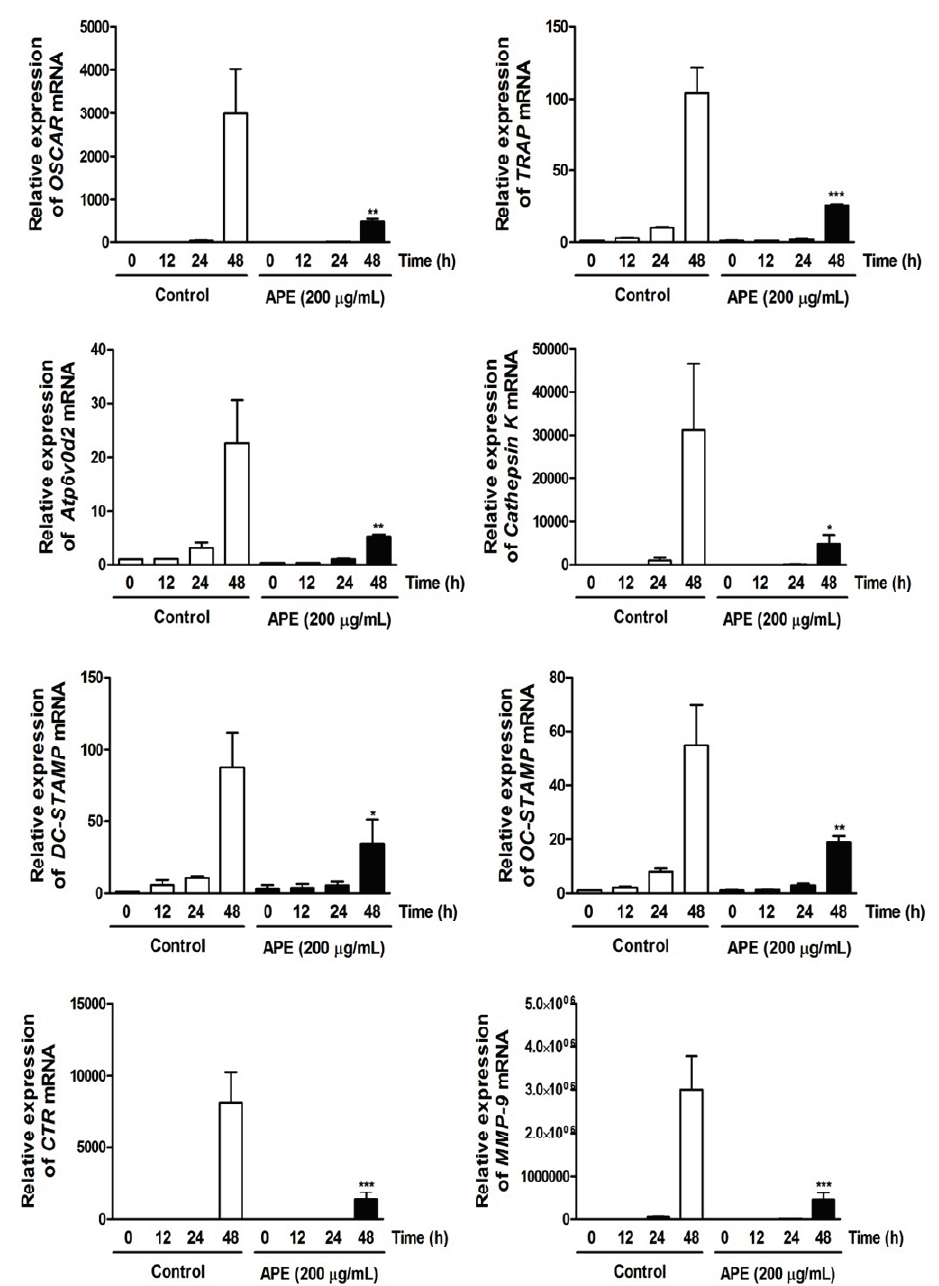
Figure 5. Aconitum pseudo-laeve var. erectum (APE) down-regulates the expression of osteoclast-specific marker genes. Bone marrow macrophages (BMMs) were stimulated with receptor activator of nuclear factor kappa-B ligand (RANKL; 100 ng/mL) and macrophage colony-stimulating factor (M-CSF; 30 ng/mL) in the presence or absence of APE (200 µg/mL) for the indicated times. Total RNA was isolated from cells using QIAzol reagent and mRNA expression levels of osteoclast-associated receptor (OSCAR), tartrate-resistant acid phosphatase (TRAP), Atp6v0d2, Cathepsin K, dendritic cell-specific transmembrane protein (DC-STAMP), osteoclast stimulatory transmembrane protein (OC-STAMP), calcitonin receptor, and matrix metallopeptidase 9 (MMP-9) were evaluated by real-time PCR.